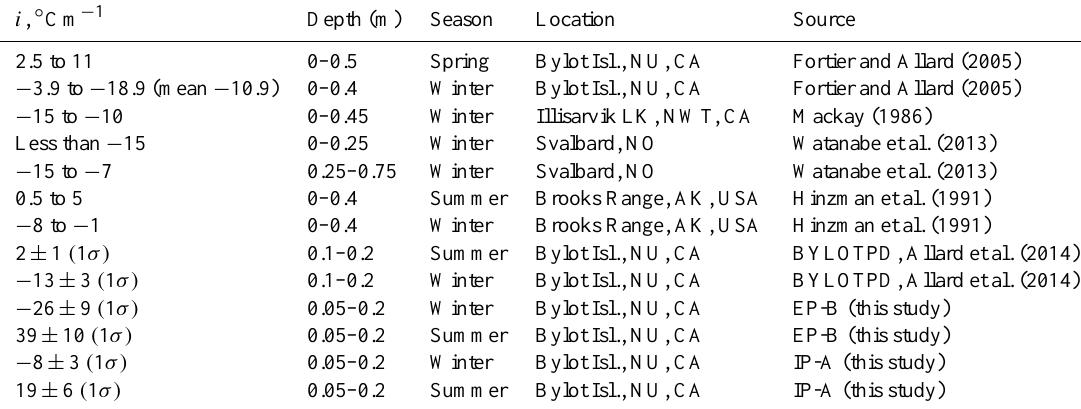
Table 4. Thermal gradients reported from the literature (as reference) and from sites in this study (EP-B, IP-A). The gradient i ◦ Cm − 1 , the depth, the season, the location and the source are mentioned. Winter thermal gradients were common while spring/summer gradients were